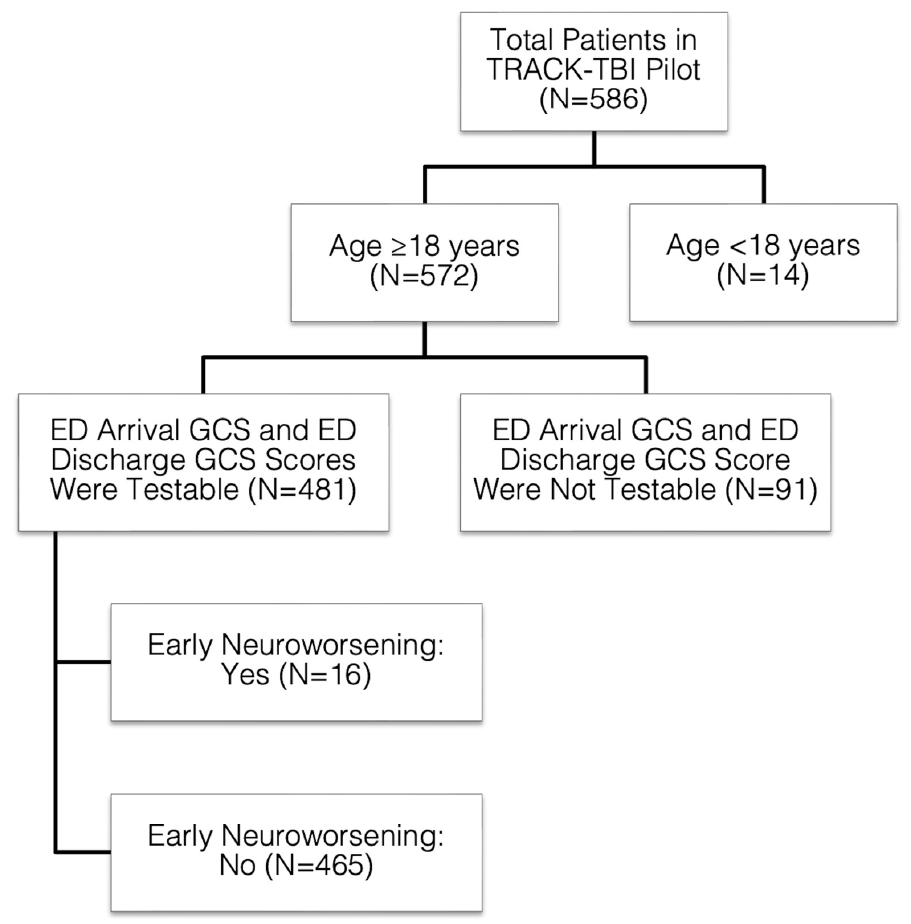
Figure 1. CONSORT Flow Diagram. Flowchart of included subjects. CONSORT = Consolidated Standards of Reporting Trials; ED = emergency department; GCS = Glasgow Coma Scale; TRACK-TBI Pilot = Transforming Research and Clinical Knowledge in Traumatic Brain Injury Pilot.